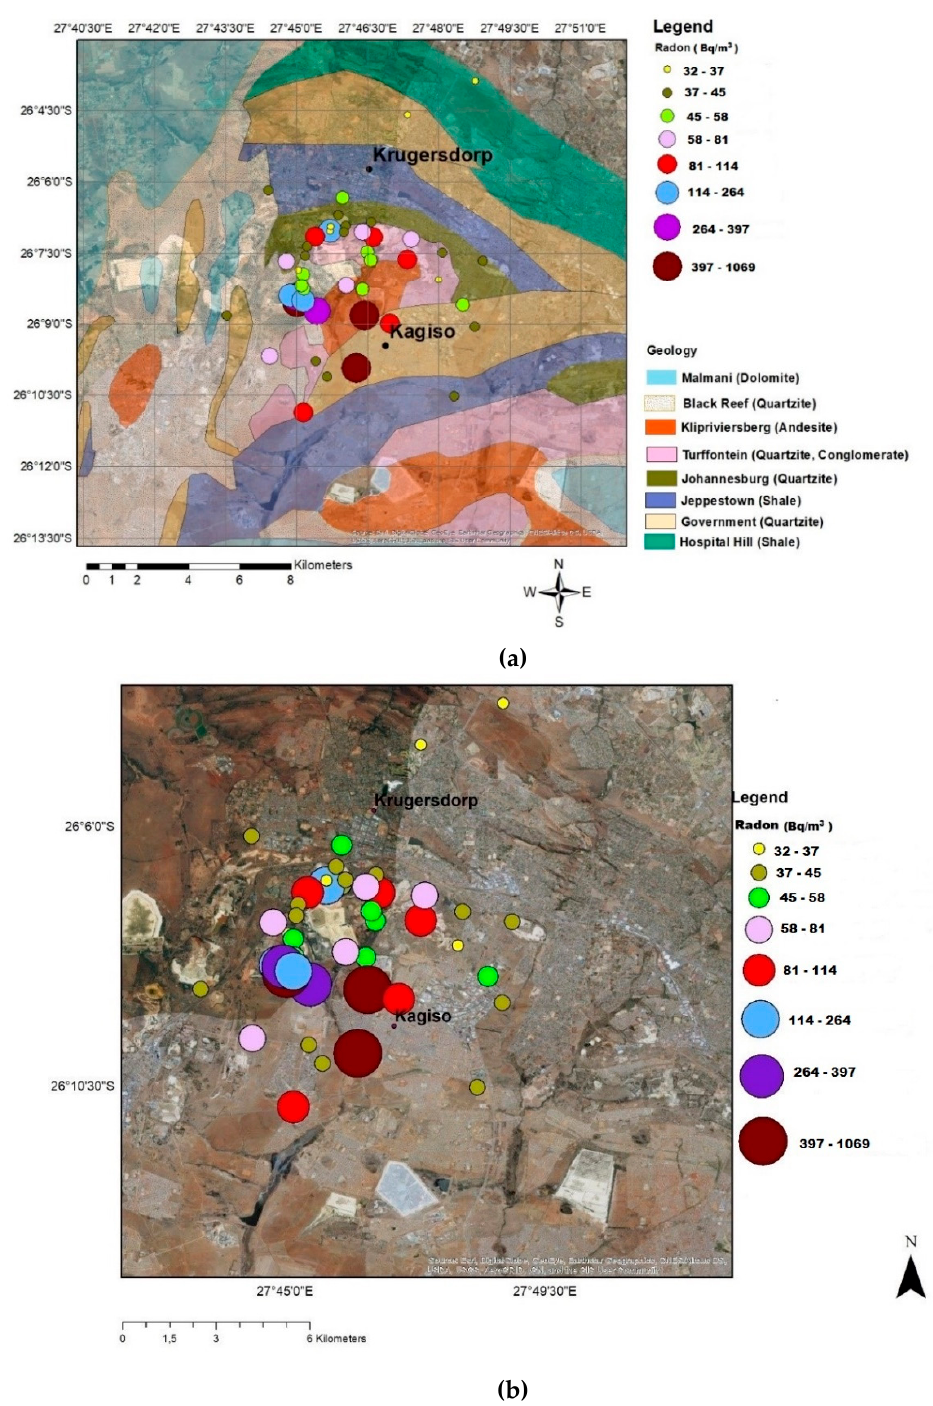
Figure 10. ( a ) Radon (Bq/m 3 ) distribution in relation to the underlying geology; ( b ) Radon (Bq/m 3 ) distribution in relation to tailings